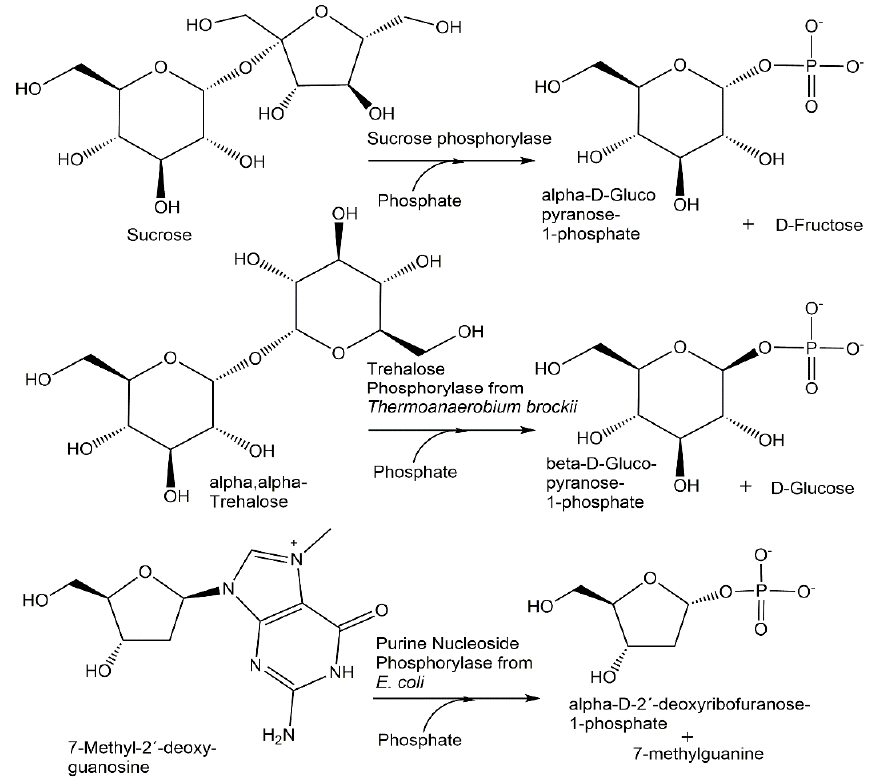
Figure 5. Selected phosphorylases for phosphorylation reactions.